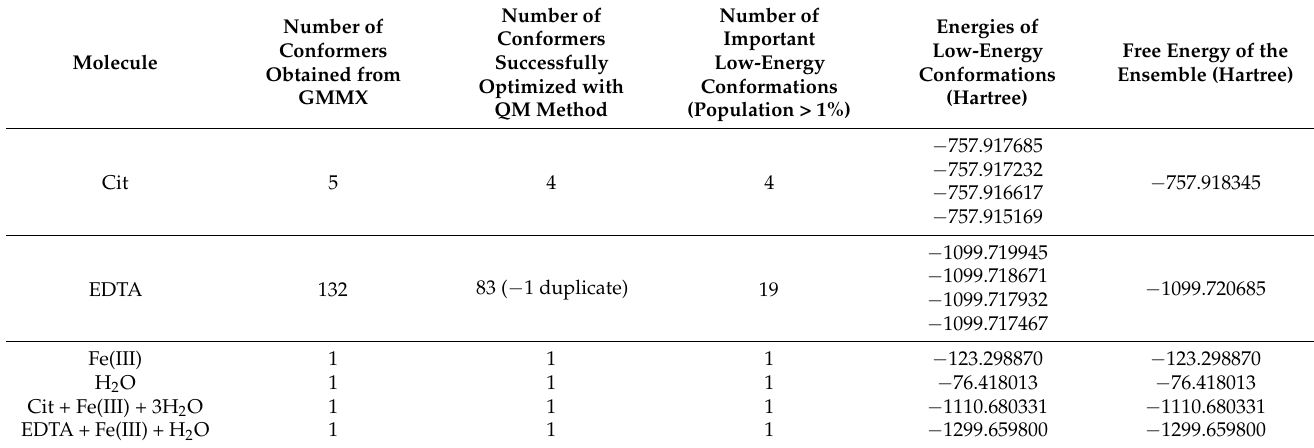
Table 5. Properties of all molecules calculated with BHANDHLYP/6-311 + G(d,p)/IEF-PCM